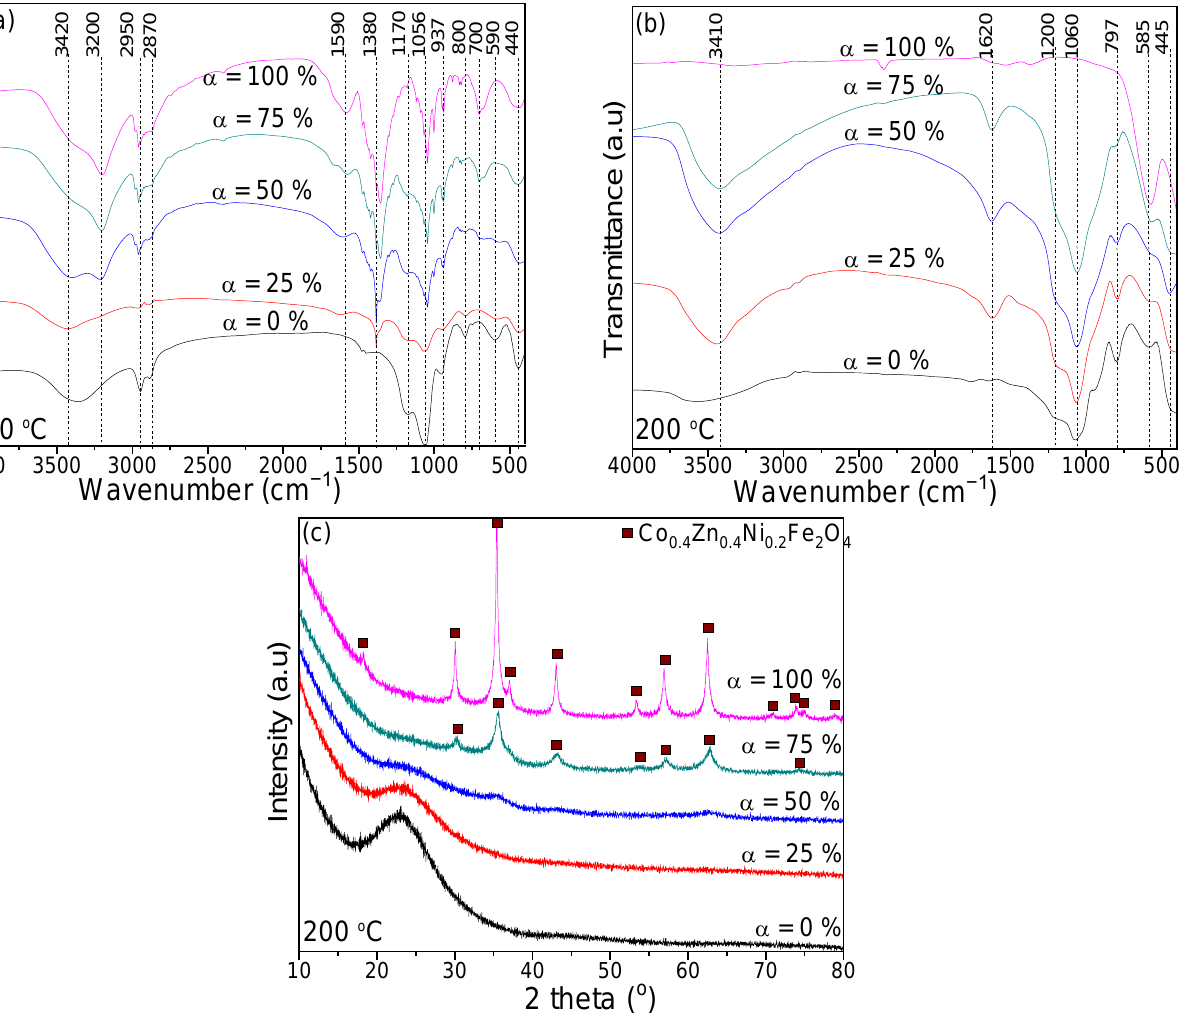
Figure 2. FT-IR spectra of (Co 0.4 Zn 0.4 Ni 0.2 Fe 2 O 4 ) α (SiO 2 ) 100 − α samples heated at 40 ◦ C ( a ) and 300 ◦ C ( b ) and XRD patterns of (Co 0.4 Zn 0.4 Ni 0.2 Fe 2 O 4 ) α (SiO 2 ) 100 − α samples at 300 ◦ C ( c